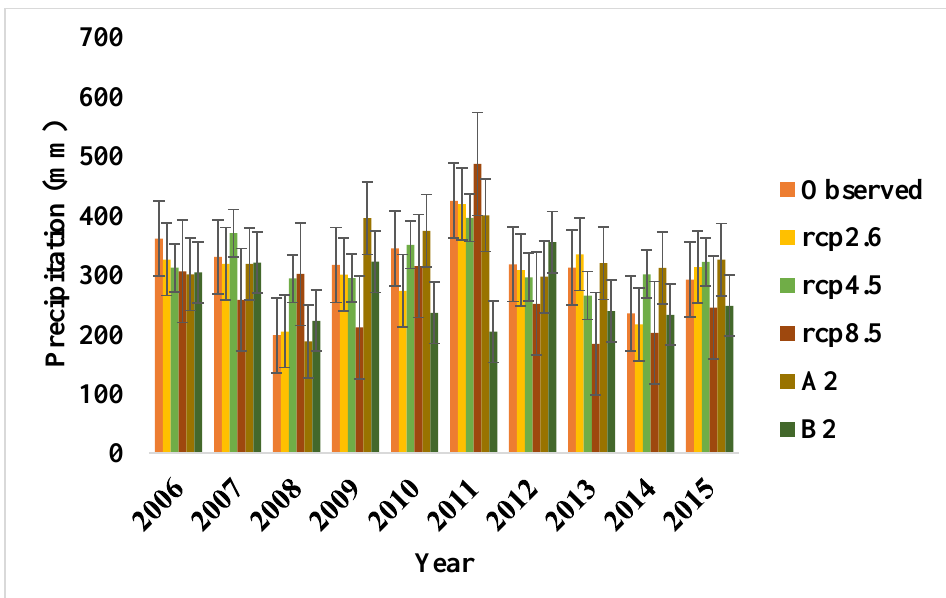
Figure 3. Results of the comparison between the observed precipitation values (2006–2015) and the simulated precipitation values. I = ± SD: standard deviation, the overlapping bars show no significant